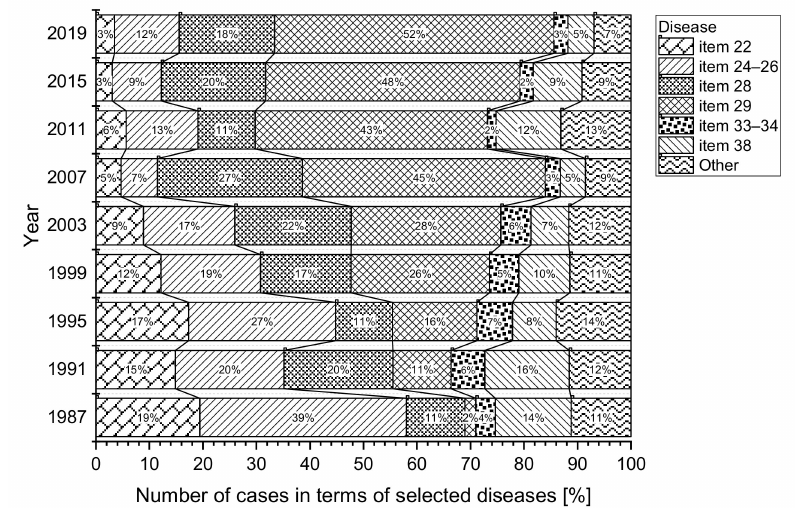
Figure 7. Percentage of the number of cases in terms of selected types of disease